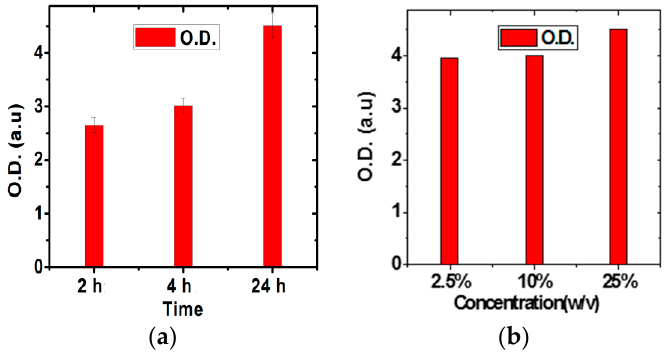
Figure 3. O.D. measurement for estimating antibody binding: ( a ) with different times for 25% Glutaraldehyde; ( b ) with different concentrations for 24 h treatment time.